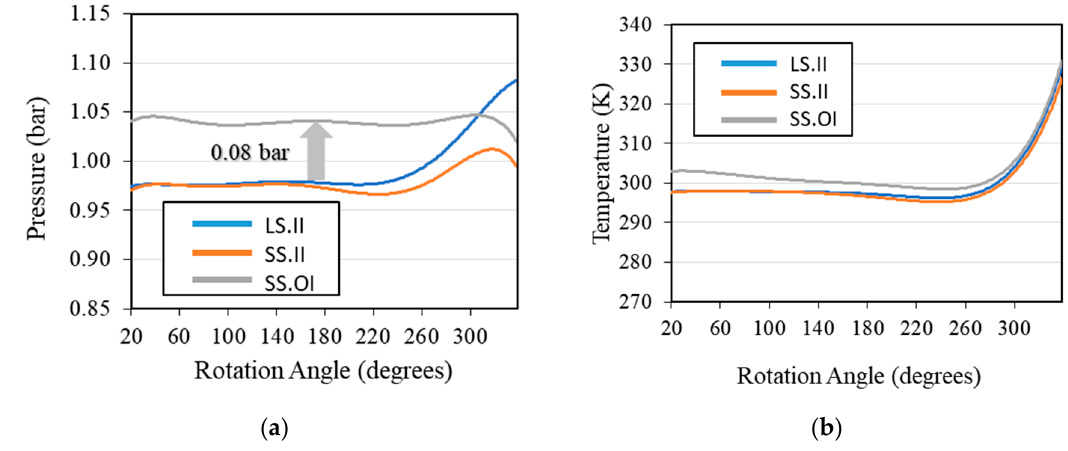
Figure 14. Pressure ( a ) and temperature ( b ) development in the intake chamber.